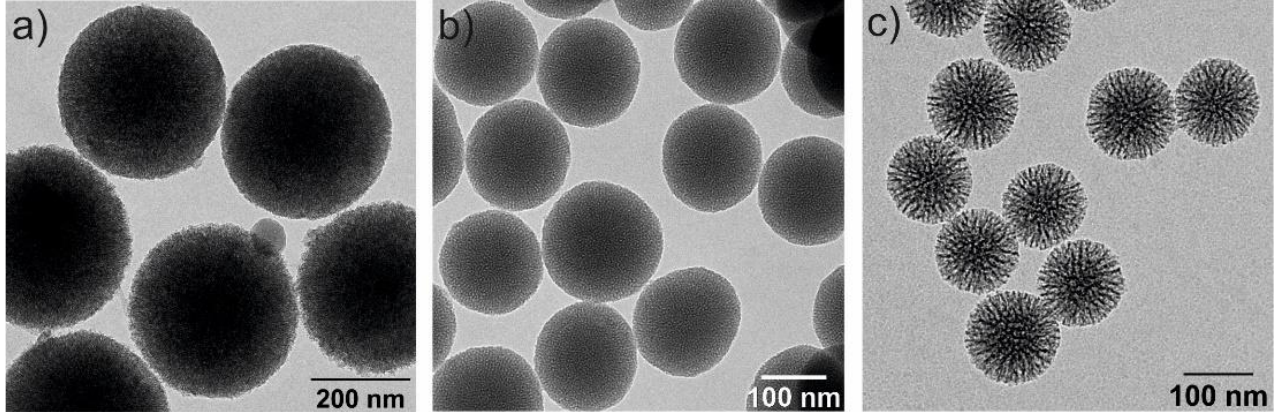
Figure 3. Transmission electron microscopy (TEM) images of three spherical MSNs with different particle and pore sizes: ( a ) 350 nm and 2 – 3 nm of pore diameter, ( b ) 150 nm size and 2 – 3 nm pore diameter and ( c ) 100 nm and 6 – 8 nm pore diameters.